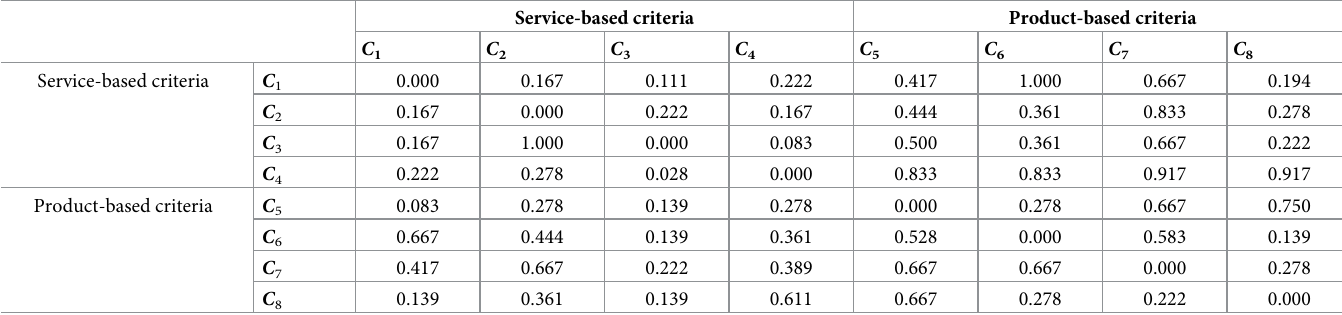
Table 6. Aggregated initial direct-influence defuzzified